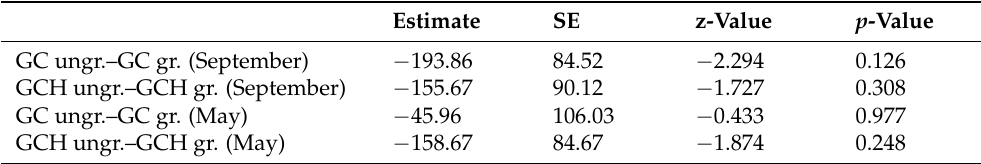
Table A20. Differences in biomasses, comparing the grazed pastures and ungrazed strips of the grass–clover (GC) and the grass–clover herbs (GCH) in May/June and September.